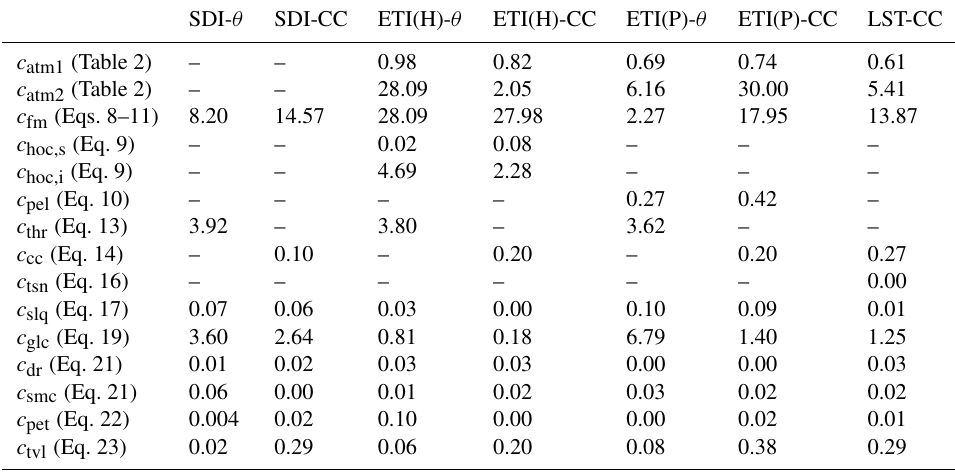
Table B1. All fitting parameters calibrated for Gulkana used in each of the models presented in Table B3.